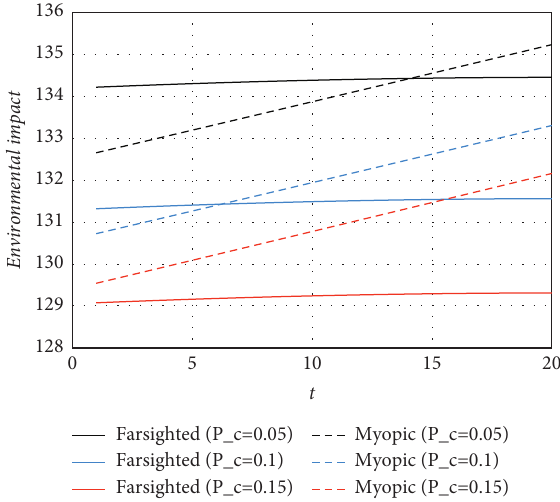
Figure 6: Impact of carbon price on